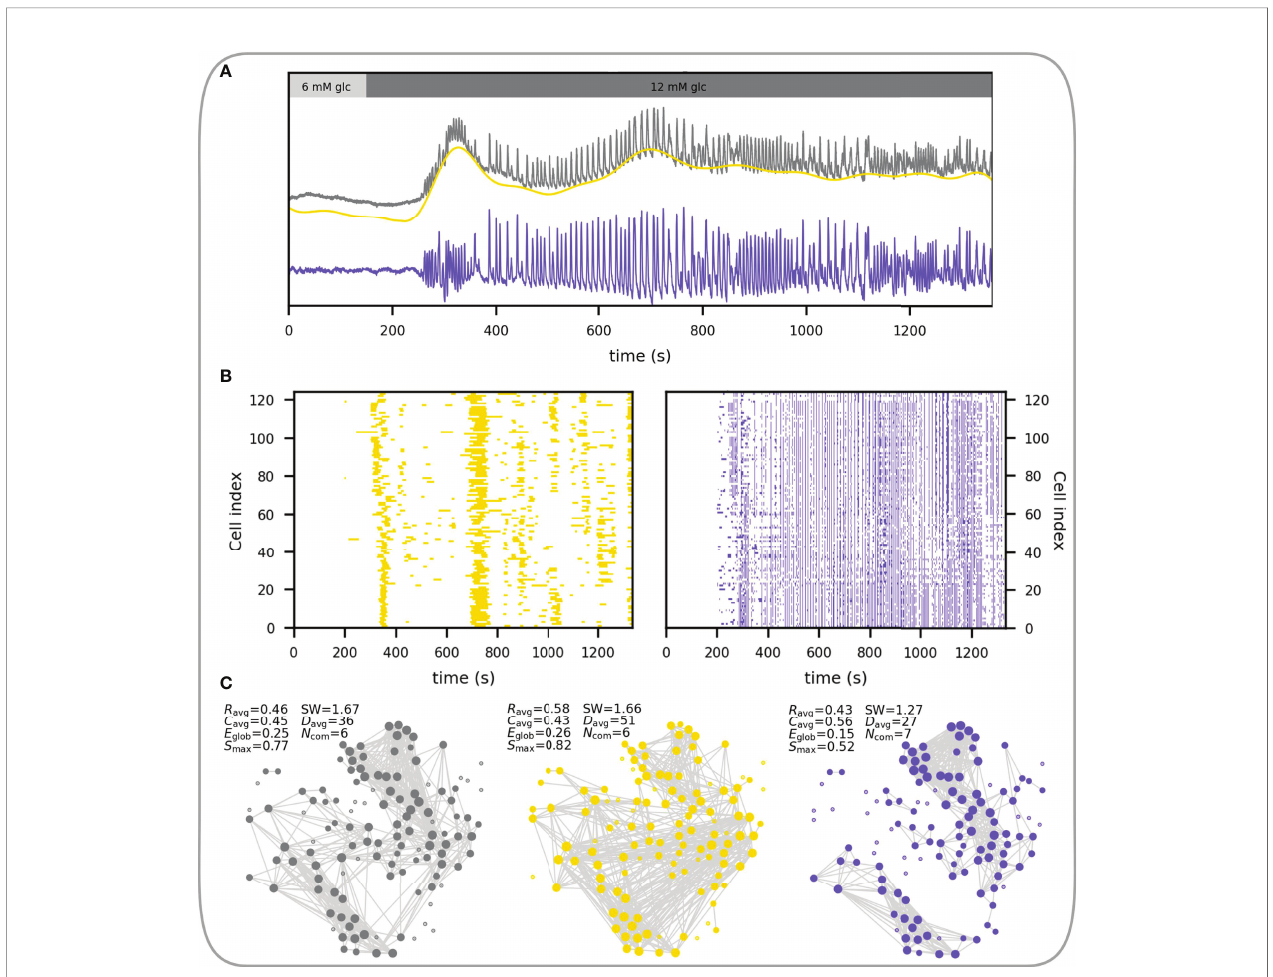
FIGURE 5 | Constructing functional beta cell networks from different types of Ca 2+ signals. (A) Raw average Ca 2+ signal of a representative islet (gray line) with extracted slow (yellow line) and fast (blue line) signal components. (B) Raster plots showing the activity of the slow (left, yellow dots) and fast (right, blue dots) Ca 2+ signals of all cells in the islet. (C) Correlation-based functional networks constructed from unprocessed (left), slow- (middle) and fast (right) Ca 2+ signals. Networks were constructed with a fi xed average network node degree k avg = 8.3. The following parameters for each functional network are provided: average correlation coef fi cient ( R avg ), average clustering coef fi cient ( C avg ), global ef fi ciency ( E glob ), largest connected component ( S max ), small-world coef fi cient (SW), average physical length of functional connections ( D avg ) and the number of communities ( N com